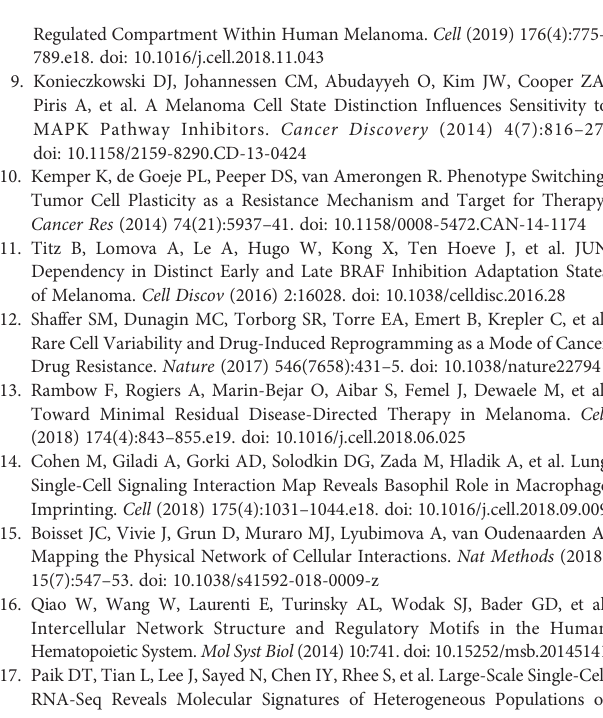
Supplementary Table 1 | TF regulons and functional signatures or markers for annotating tumor cells and CD8+ T cell states. Supplementary Table 2 | Ligand-receptor